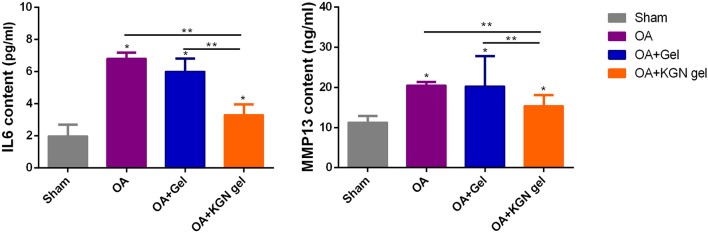
ELISA method detecting IL-6 and MMP-13 content in synovial fluid of all groups at 6 weeks (n = 8, *p < 0.05, **p < 0.01).